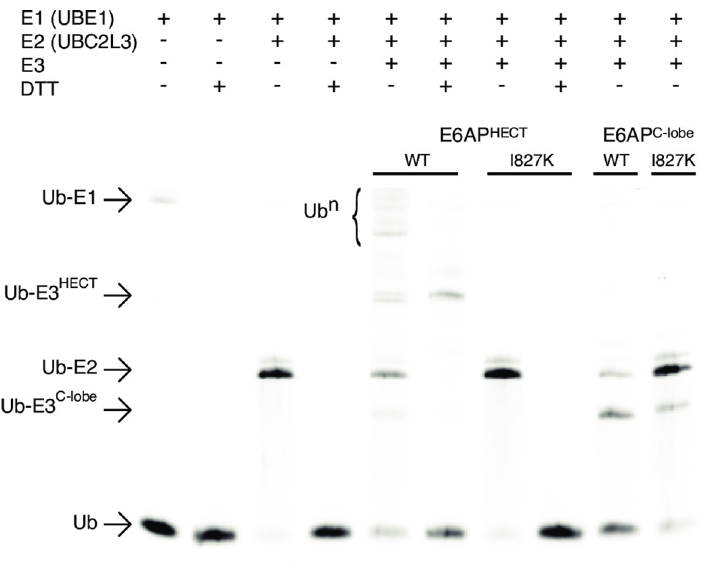
Fig 2. E6AP I827K is a loss of function substitution. The ubiquitylation activity assay of wildtype or I827K substituted E6AP HECT and E6AP C-lobe consisted of a 30-minute incubation at 37˚C of various combinations of 10 μ M ubiquitin N -terminally tagged with Alexa Fluor 647, 10 μ M E1 ubiquitin activating enzyme (UBE1), 10 μ M E2 ubiquitin conjugating enzyme (UBE2L3), and 35 μ M E3 ubiquitin ligase in a buffer containing 50 mM HEPES pH 7.5, 100 mM NaCl, 16 mM ATP, and 40 mM MgCl 2 . 10 mM DTT was added to alternate samples to reduce any thioester bonds present. The samples were run by electrophoresis a 15% Bis-Tris polyacrylamide gel and visualized on a ThermoFisher iBright FL1000 imaging